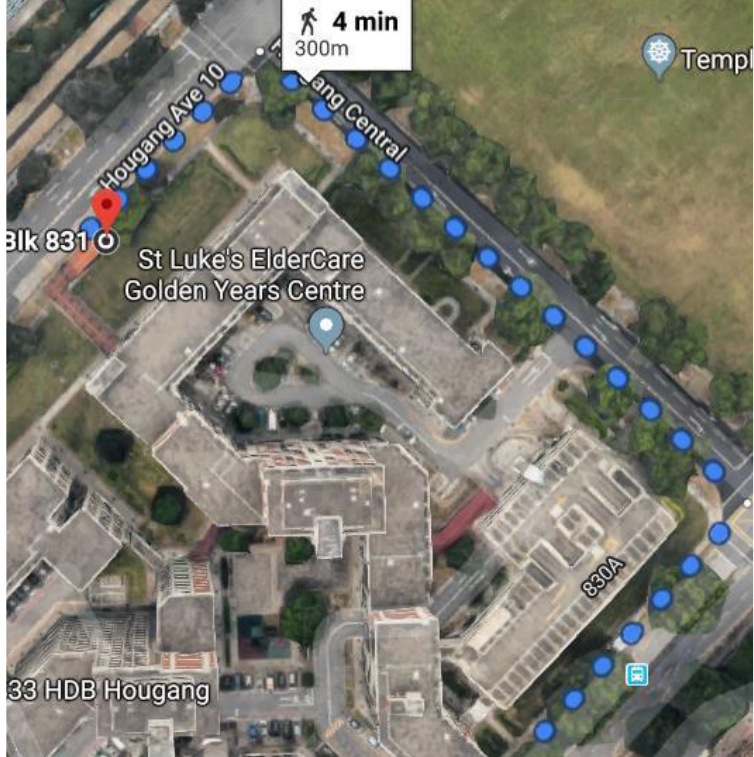
Figure 2. Location of the HDB ’ s covered linkway.